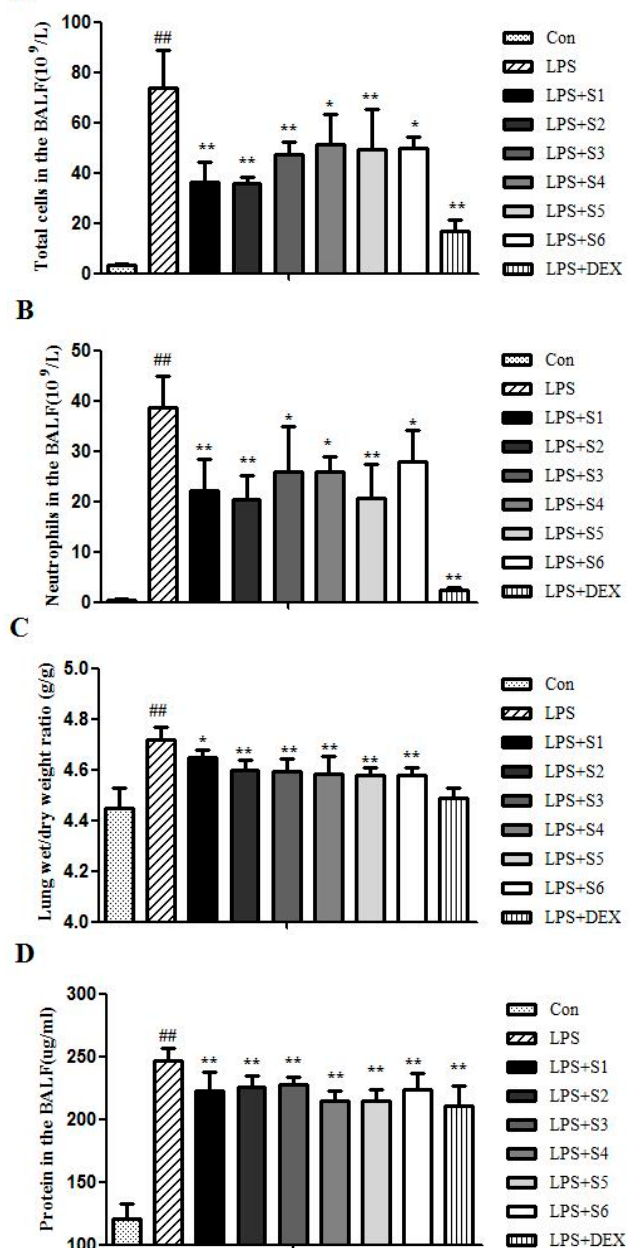
Figure 3. Effects of QBD on LPS induced lung injury and edema. Rats were administrated with different extracts of QBD (S1, S2, S3, S4, S5 and S6) 1h before intratracheal instillation of LPS (5 mg/kg).